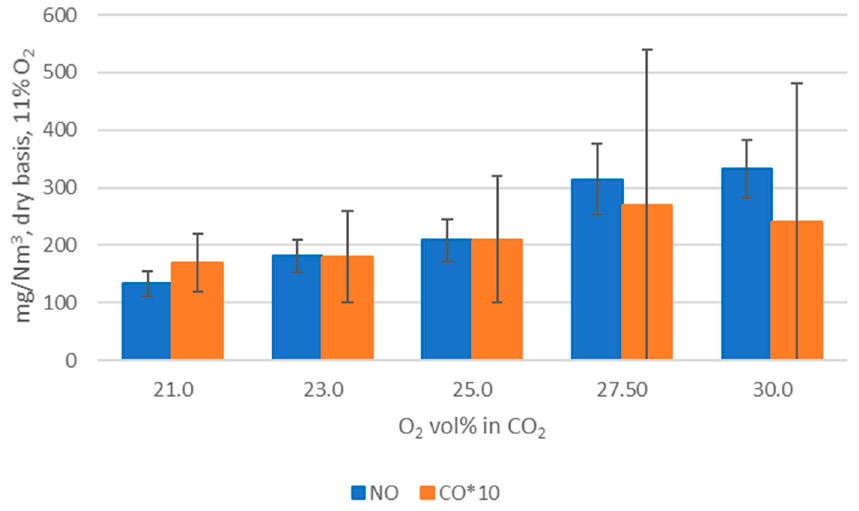
Energies 2021 , 14 , x FOR PEER REVIEW Figure 6. NO and CO emissions (with standard deviation) with different O 2 /CO 2 oxidizer mix. Figure 6. NO and CO emissions (with standard deviation) with different O